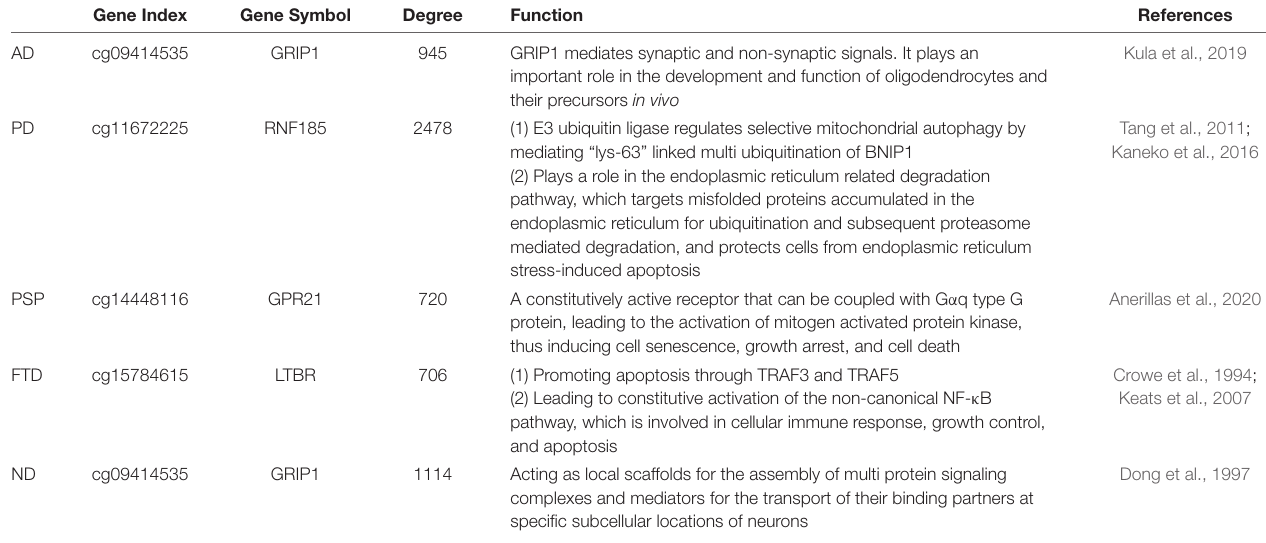
TABLE 4 | Network markers of the highest